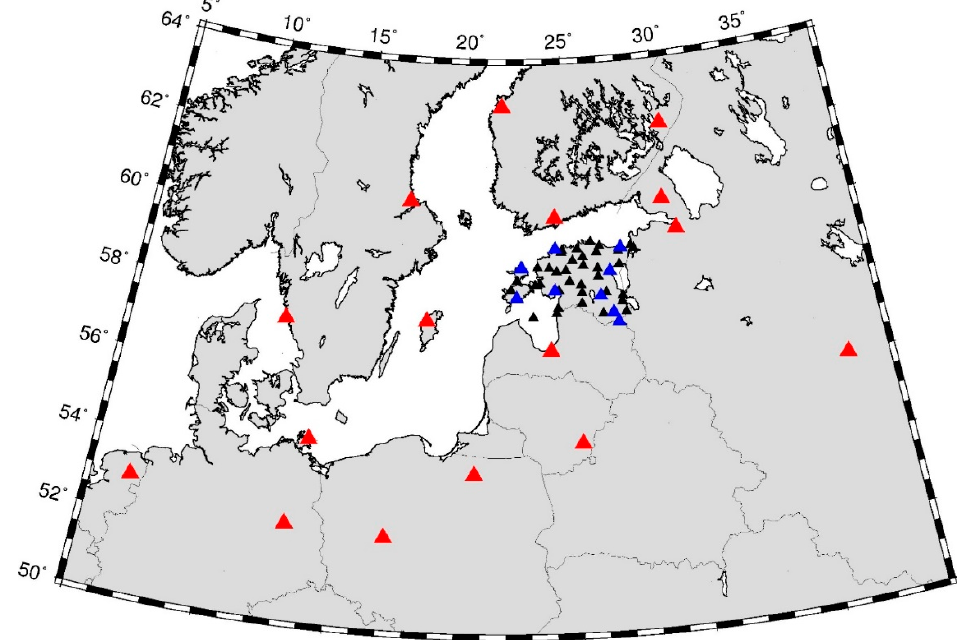
Figure 2. Dense network of cGNSS stations (black and blue triangles) used in Bernese 5.2 (BERN) adjustment. Ten stations used for time-series analysis in the current study are indicated as blue triangles. Fiducial stations in the adjustment are marked with red triangles.